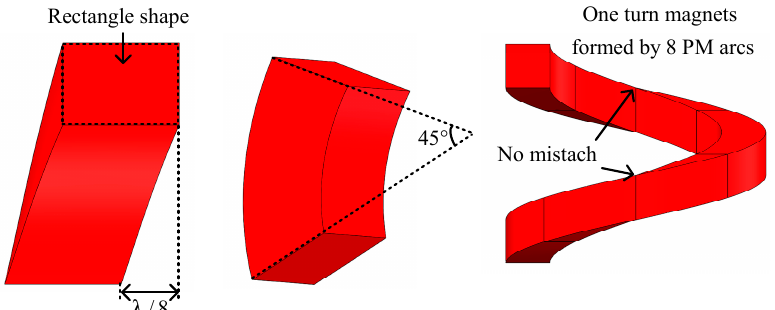
Figure 14. Schematic view of the proposed PM arc and one-turn magnets formed by 8 PM arcs.